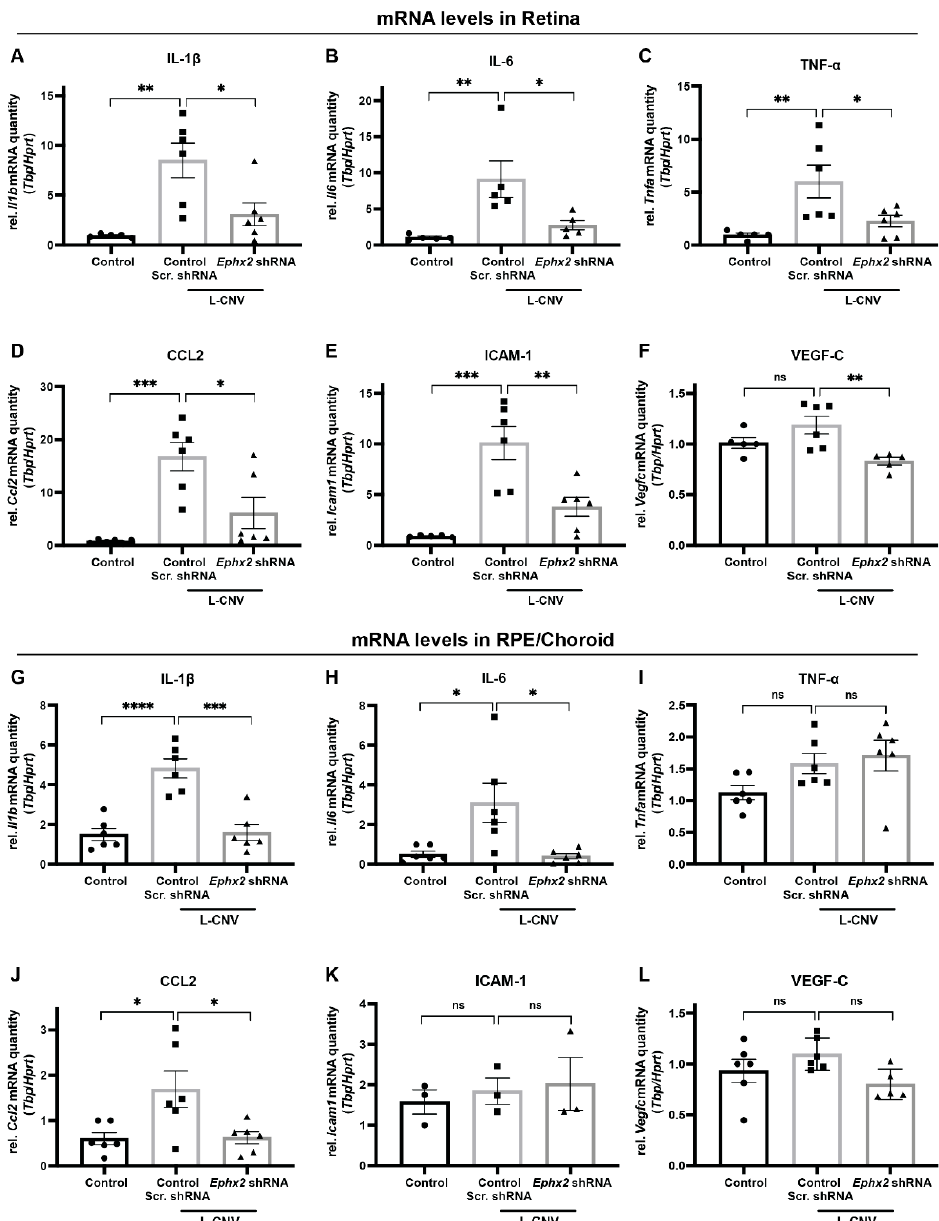
Figure 8. Inhibition of CNV-related inflammatory molecule expression by AAV8 delivery of Ephx2 shRNA. mRNA expression levels of inflammatory molecules ( A , G ) Il1b , ( B , H ) Il6 , ( C , I ) Tnfa , ( D , J ) Ccl2 , ( E , K ) Icam1 , and ( F , L ) Vegfc in the retina ( A – F ) or RPE/choroid ( G – L ) of untreated control and L-CNV mice transduced with control scrambled shRNA or Ephx2 shRNA. qPCR data for the indicated genes relative to Tbp and Hprt expression, normalized to a single control sample. Mean ± SEM, n = 3–6 biological replicates (each data point represents pooled tissue from 2 eyes), one-way ANOVA with Tukey’s post hoc tests (ns, non-significant; * p < 0.05; ** p < 0.01; *** p < 0.001; **** p < 0.0001). RPE, retinal pigment epithelium; Scr, scrambled. 2.8. sEH Lipid Substrate 19,20-EDP Is Antiangiogenic in the Eye